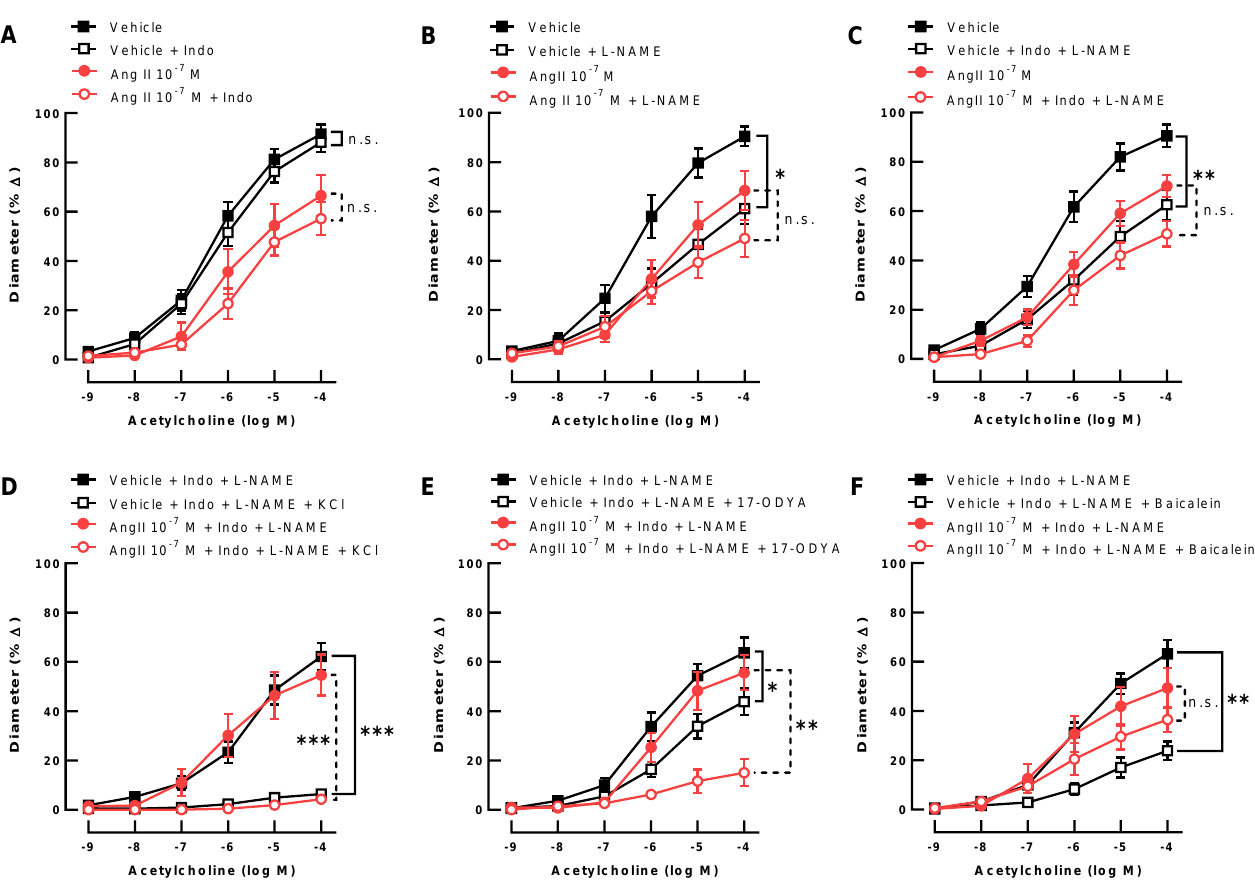
Figure 5. The non-isoform-selective COX blocker, indomethacin (Indo), had no effect on the acetylcholine-induced (endothelium-dependent) vasodilation in the vehicle-incubated and Ang II 10 − 7 M-incubated ophthalmic arteries from wild-type mice (C57BL/6J) ( A ). In contrast, the non-isoform-selective NOS inhibitor, L-NAME, markedly reduced the endothelium-dependent vasodilation in the vehicle-incubated arteries, but only had a negligible effect in Ang II-incubated arteries ( B ) (* p < 0.05, vehicle + L-NAME versus vehicle). Also, the combined blockade of COX and NOS significantly reduced endothelium-dependent vasodilation in vehicle-incubated but not in Ang II-incubated ophthalmic arteries ( C ) (** p < 0.01, vehicle + Indo + L-NAME versus vehicle). KCl (30 mM), which prevents hyperpolarization, virtually abolished endothelium-dependent vasodilation in both vehicle- and Ang II-incubated vessels, in which COX and NOS had been blocked, indicative of substantial EDHF involvement ( D ) (*** p < 0.001, vehicle + Indo + L-NAME + KCl versus vehicle + Indo + L-NAME and Ang II 10 − 7 M + Indo + L-NAME + KCl versus Ang II 10 − 7 M + Indo + L-NAME). Inhibition of CYP450 by 17-ODYA moderately blunted acetylcholine-induced vasodilation in vehicle-incubated ophthalmic arteries. Remarkably, the blocking effect was much more pronounced in the Ang II-exposed arteries ( E ) (* p < 0.05, vehicle + Indo + L-NAME + 17-ODYA versus vehicle + Indo + L-NAME; ** p < 0.01, Ang II 10 − 7 M + Indo + L-NAME + 17-ODYA versus Ang II 10 − 7 M + Indo + L-NAME). The 12/15-LOX inhibitor, baicalein, markedly reduced endothelium-dependent vasodilation in the vehicle-treated ophthalmic arteries, while having no significant effect on Ang II-treated ophthalmic arteries ( F ) (** p < 0.01, vehicle + Indo + L-NAME + Baicalein versus vehicle + Indo + L-NAME). Data are expressed as mean ± SE ( n = 8 per